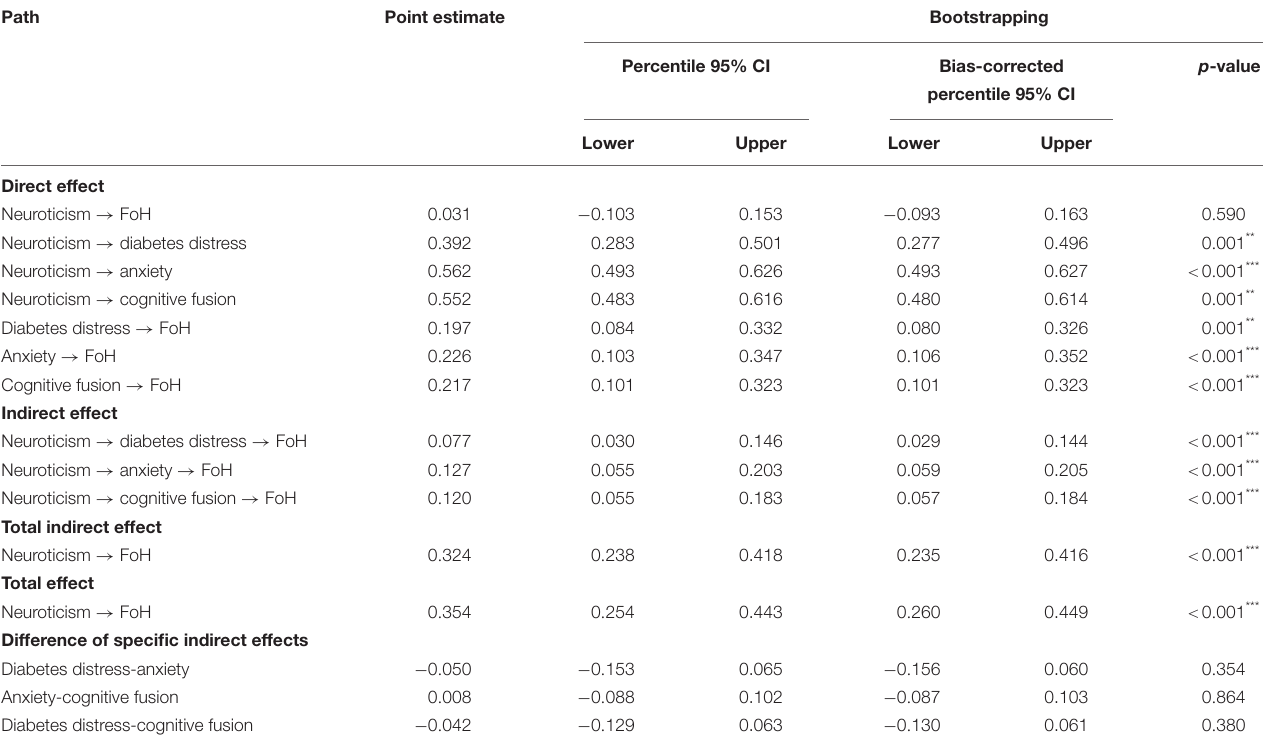
TABLE 6 | Direct, indirect, and total effects of the parallel mediation model with mediator of diabetes distress, anxiety, and cognitive fusion.